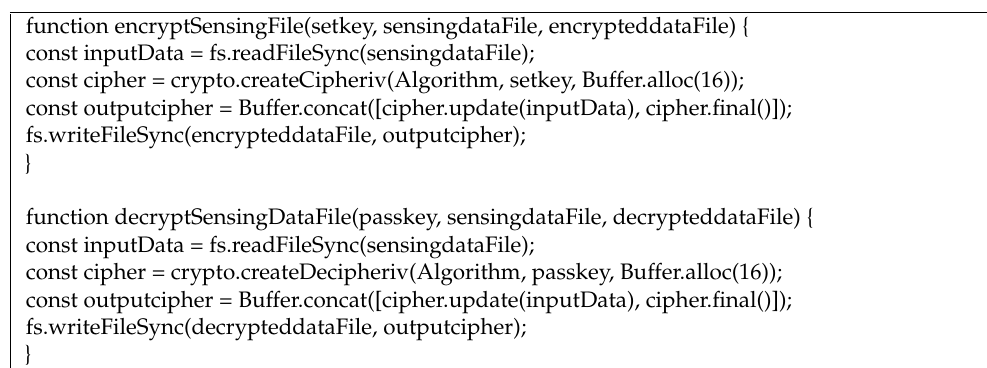
Table 2. Symmetric method